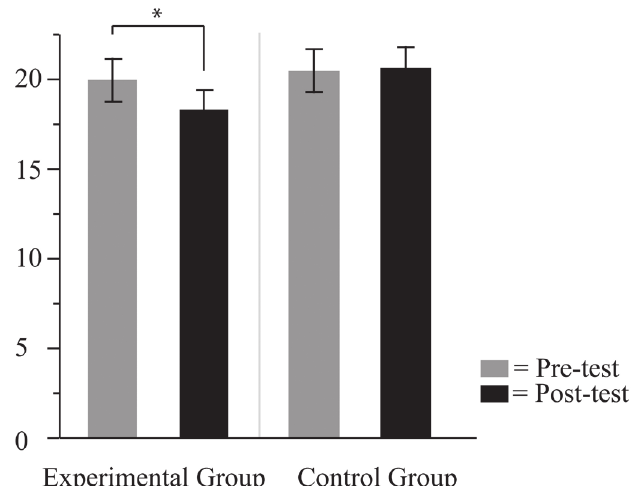
FIGURE 3. The Average value of Social Communication Questionnaire between experimental and control groups within pre- to post-tests.